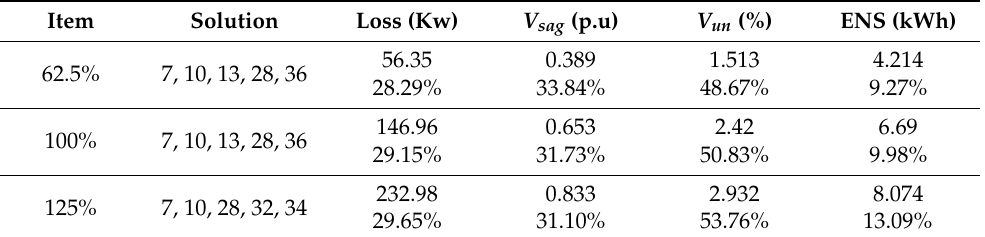
Table 6. Comparison of results of different loadings by AEFAPS for an unbalanced 33-bus network.